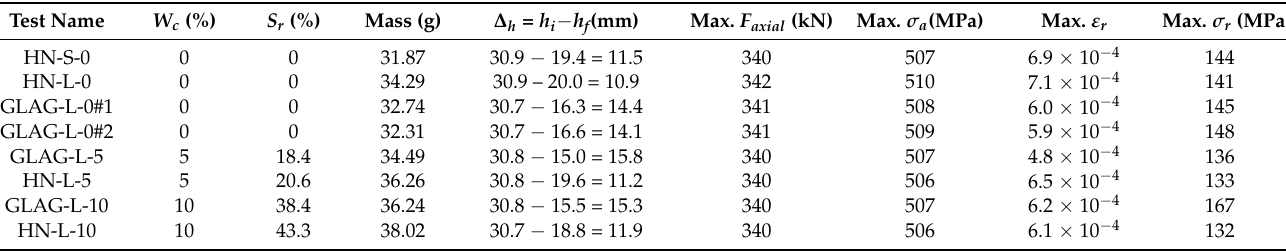
Table 3. Recapitulative table of quasi-oedometric test results.